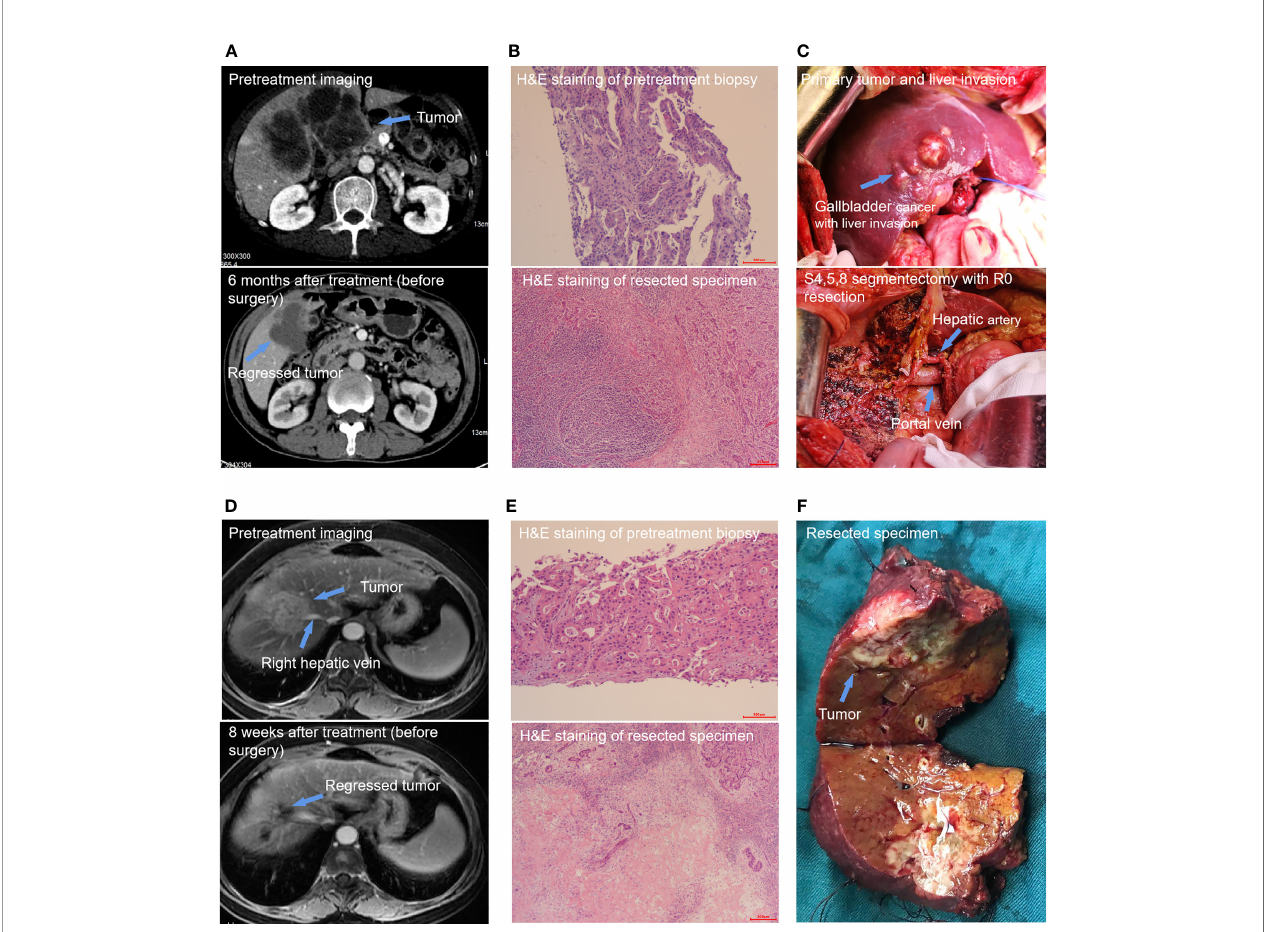
FIGURE 3 | Two special cases report. (1) Patient 11 was a 65-year-old male patient with stage IIIB gallbladder cancer. Pretreatment contrast-enhanced computed tomography (CT) imaging of the abdomen showed a huge tumor including the primary tumor and liver invasion. The tumor was signi fi cantly shrunk after 6 months of conversion treatment (A) . Hematoxylin and eosin staining of resected specimen showed a MPR and a plenty of lymphocyte in fi ltration (B) . S4,5,8 segmentectomy with R0 resection (C) . (2) Patient 24 was a 65-year-old female patient with stage II intrahepatic cholangiocarcinoma. The pretreatment Magnetic Resonance Imaging (MRI) imaging showed a primary tumor mass of 5.2 cm in diameter and has invaded the main branch of the right hepatic vein. A scan performed before surgery showed that most of the primary tumors had appeared necrosis and shrunk signi fi cantly (D) . The pathologic images shown are representative sections of the patient before conversion therapy and large amount of post-treatment necrosis and tumor-in fi ltrating lymphocytes and macrophages were found in the primary tumor postoperation (E) . Specimen with R0 resection (F)